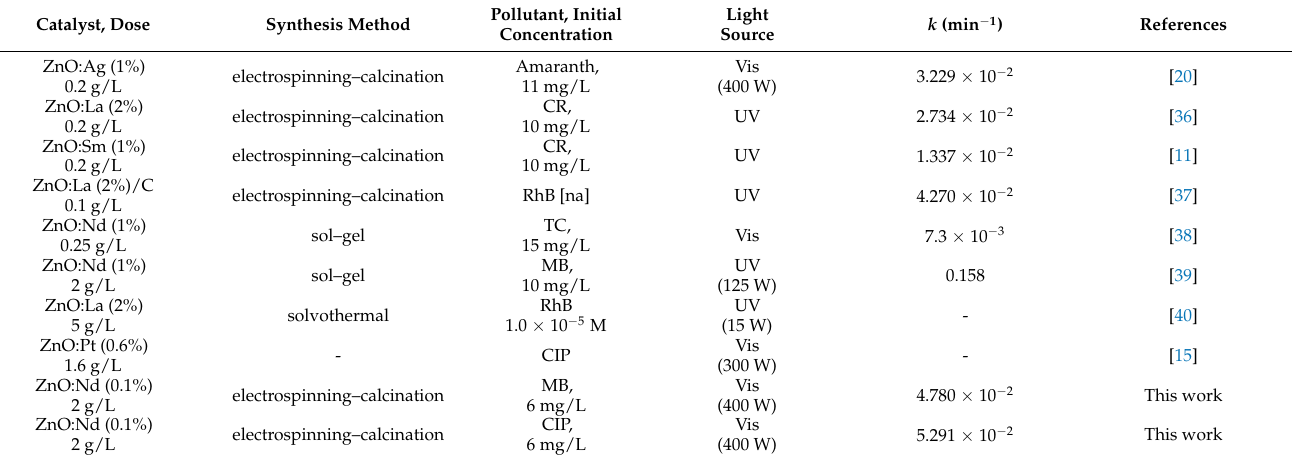
Table 5. Comparative data of existing ZnO-based materials in the literature for the degradation of different